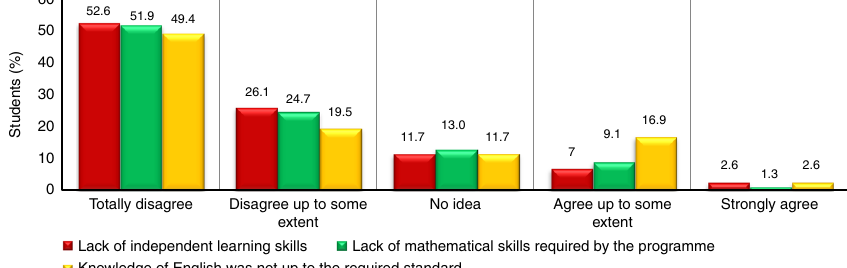
Figure 8. Learner satisfaction rates regarding ODL tools and formative/ summative evaluation criteria used within the